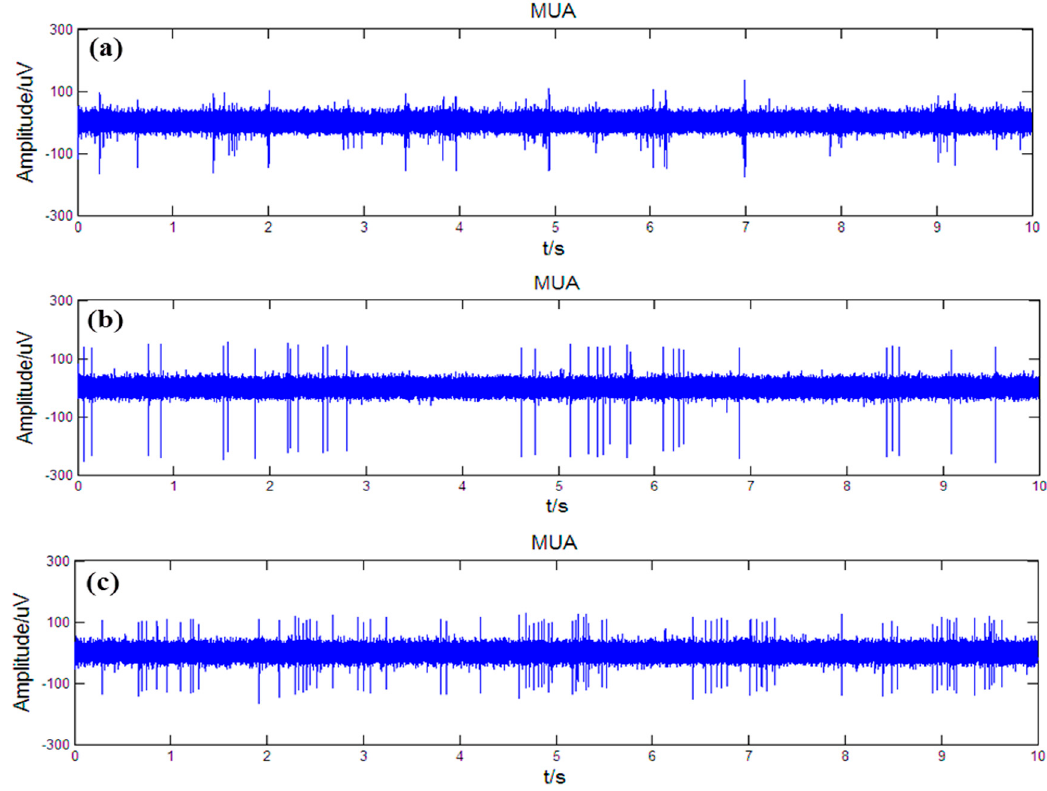
Figure 13. Simultaneously recorded MUA from striatum ( a ); GPi ( b ) and STN ( c ).